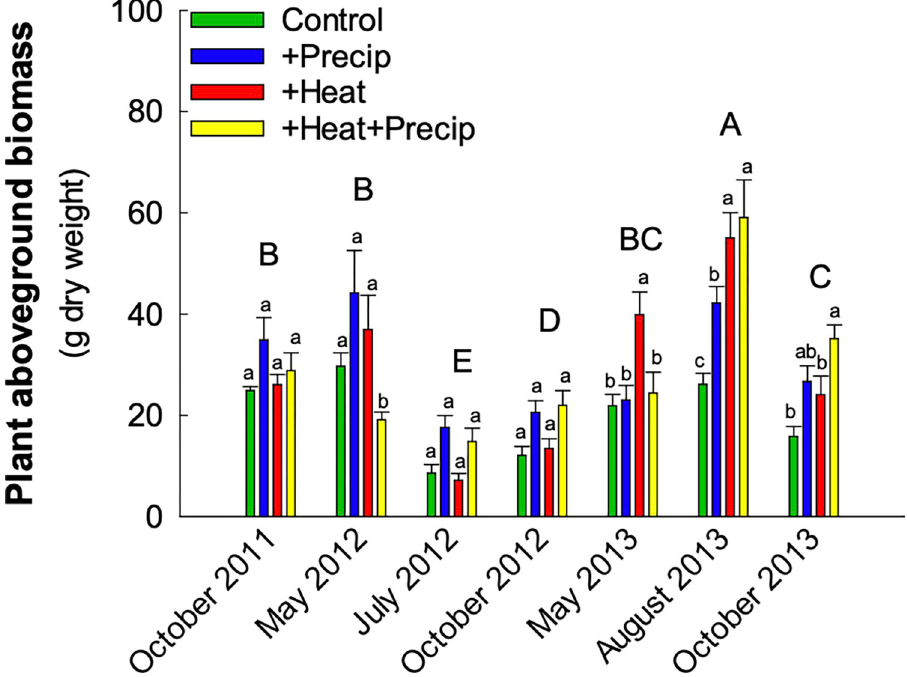
Fig 3. Average ( ± S.E.) plant biomass per ring harvested in each climate treatment from October 2011 to October 2013. Capital letters denote significant differences across the harvests, and lowercase letters denote significant across climate treatments within each